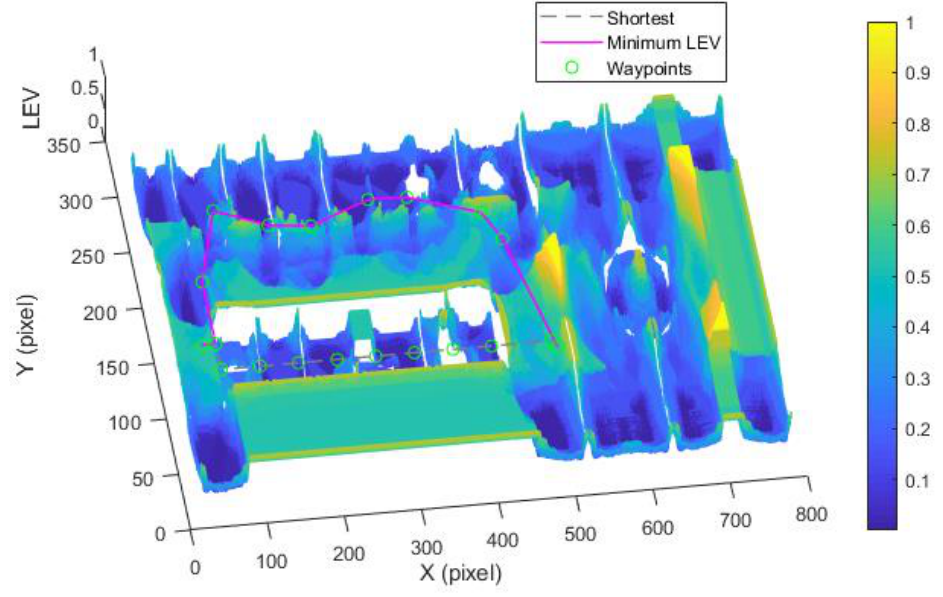
Figure 11. Optimal trajectory based on minimum localization error in the long corridor region.